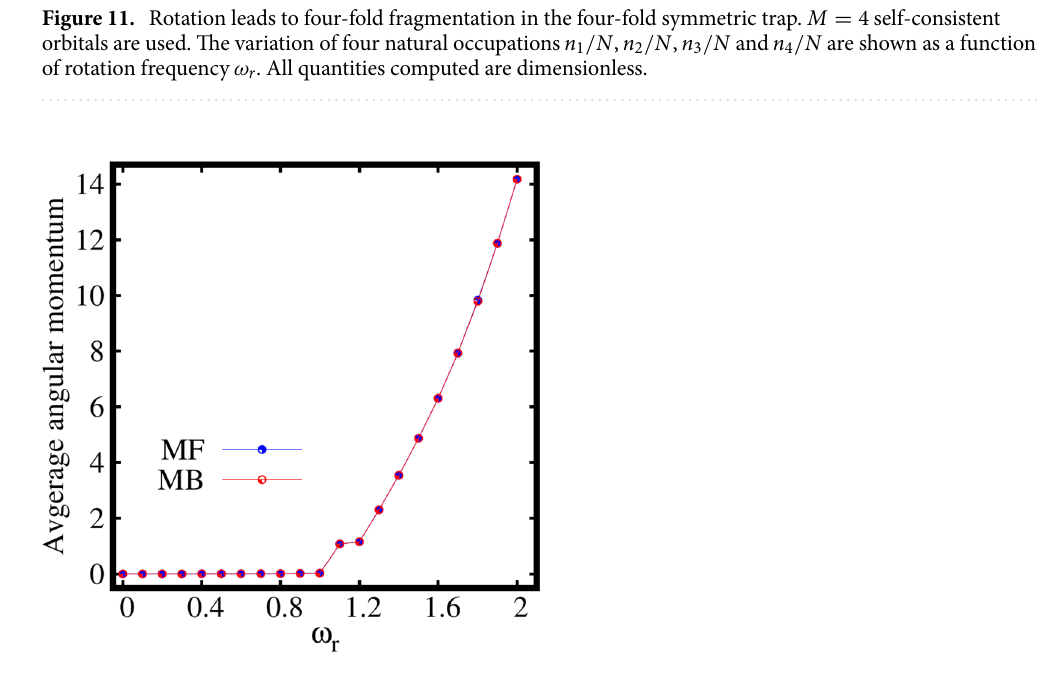
Figure 12. Expectation value of angular momentum operator �ˆ L Z � / N , computed at the mean-field (MF) and many-body (MB) levels [with M = 1 and M = 4 self-consistent orbitals, respectively] as a function of the rotation frequency ω r for the four-fold symmetric trap. All quantities shown are